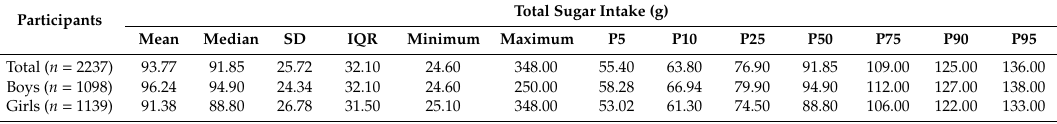
Table 1. Total sugar intake consumed by 6–8 years old children ( n = 2237) in Valencia, Spain, 2018. Participants Total Sugar Intake (g) Mean Median SD IQR Minimum